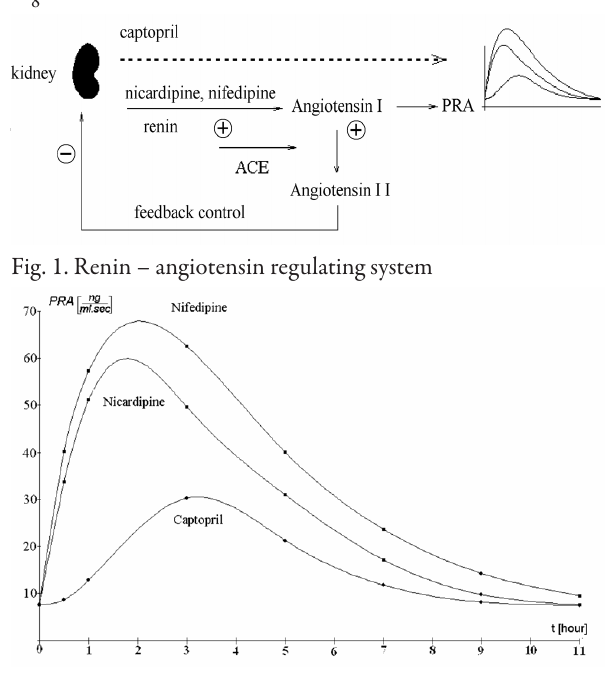
Fig. 2. PRA after treatement with dose 60mg/kg b.w.